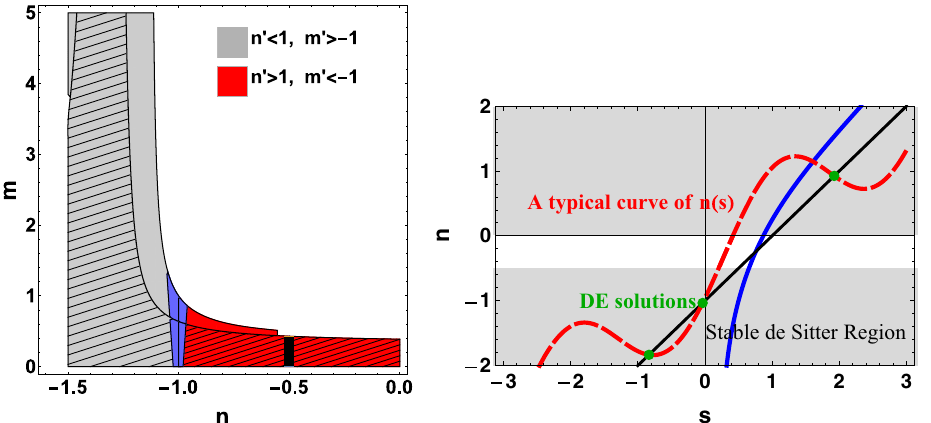
Fig. 1 The left panel shows the the stability region of fixed point P 6 . Hatched areas show spiral stability. The black region which occurred in n = − 1 / 2 indicates the situation of the conserved model f ( R , T ) = +√ − T . The blue colored regions show solutions which are com- g ( R ) patiblewithPlanck2015datafordarkenergyequationofstate.The right panel in the gray areas show the regions in which de Sitter solutions are